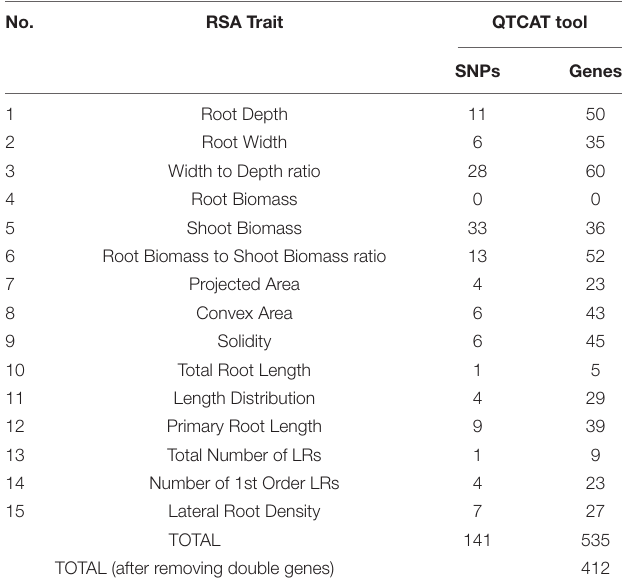
TABLE 4 | Summary of single nucleotide polymorphisms (SNPs) and genes discovered by QTCAT analysis on 15 RSA traits on 241 Arabidopsis accessions.